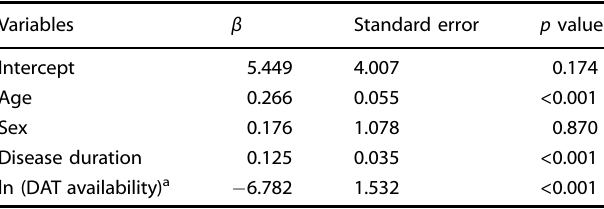
Table 2. General linear model for the prediction of UPDRS-III